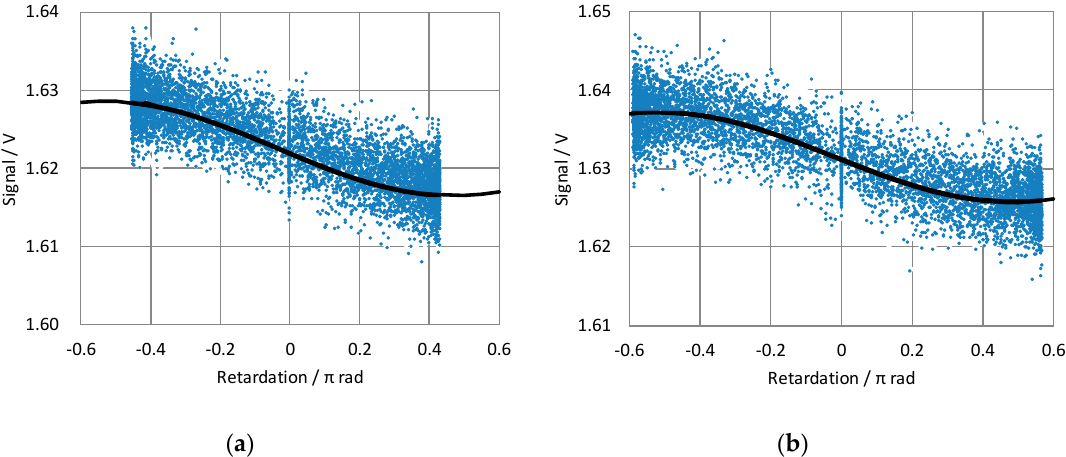
Figure 2. Retardation domain charts of the sample. The peak transmitted wavelength of the monochromatic filter was 280 nm. The peak retardation settings of the photoelastic modulator (PEM) were 0.5 π at ( a ) 254 nm and ( b ) 320 nm. The blue dots represent raw data, while the black lines represent the results of curve fitting according to Equation (3).